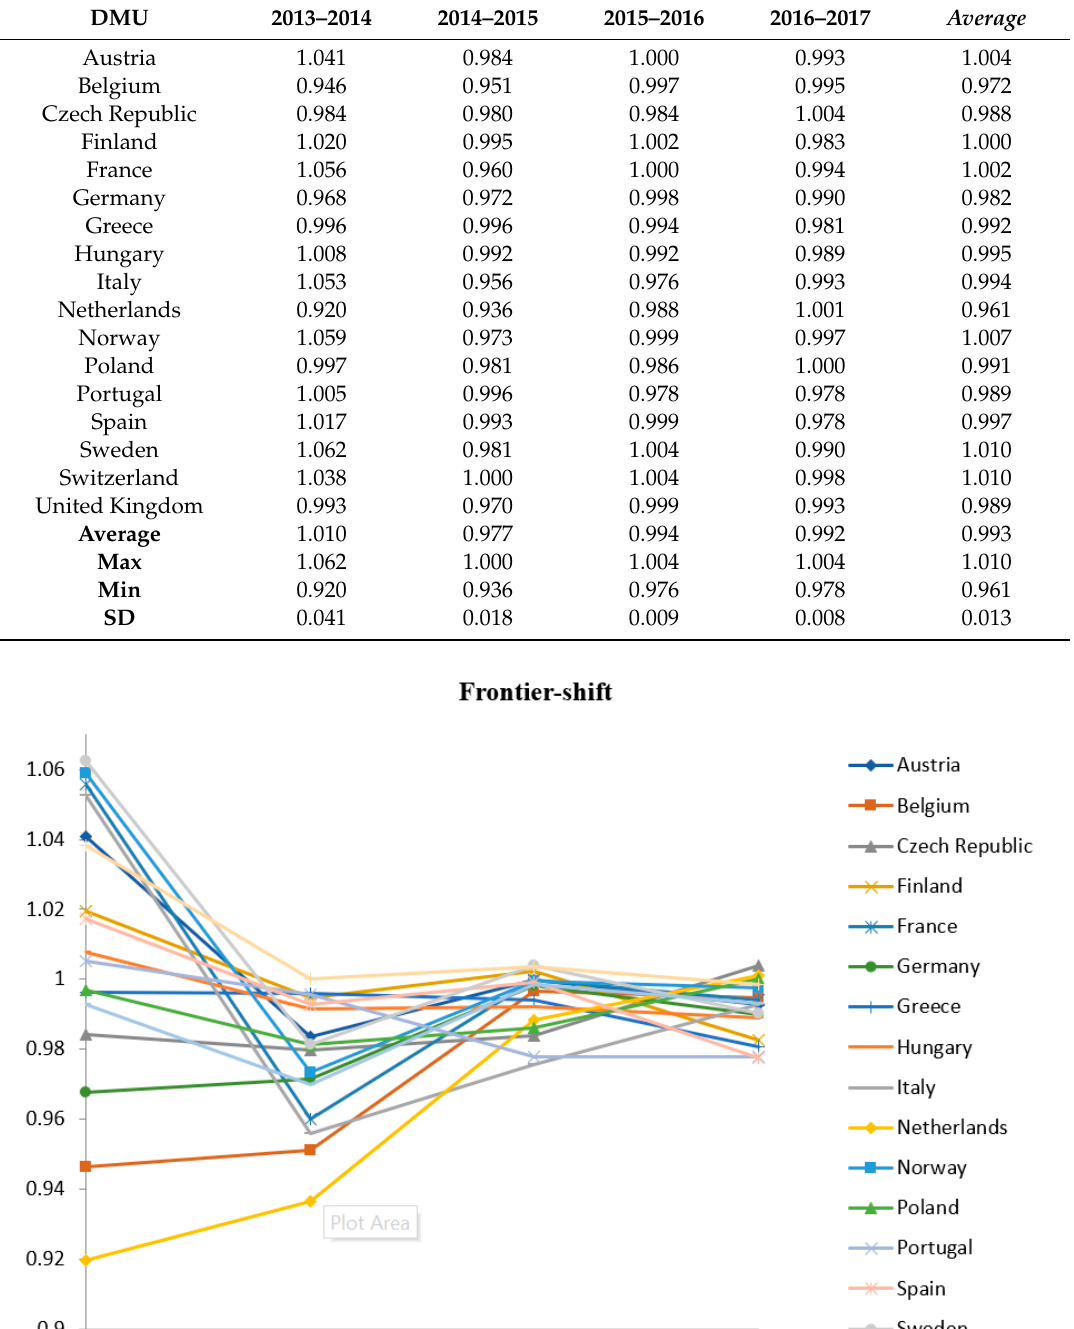
Table 8. Year-on-year technological e ffi ciency change for the 17 DMUs from 2013 to 2017.